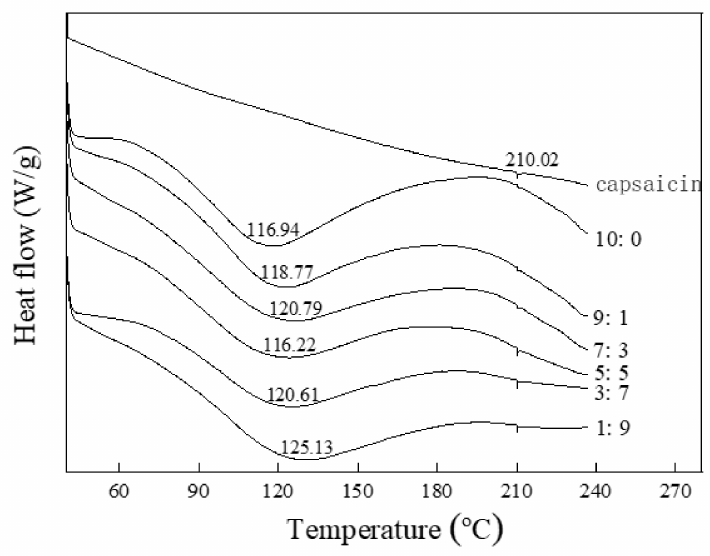
Figure 5. DSC thermograms of whey protein–citrate starch–capsaicin microcapsules. The labels 10:0, 9:1, 7:3, 5:5, 3:7, and 1:9 represent the ratio of whey protein to citrate mung bean